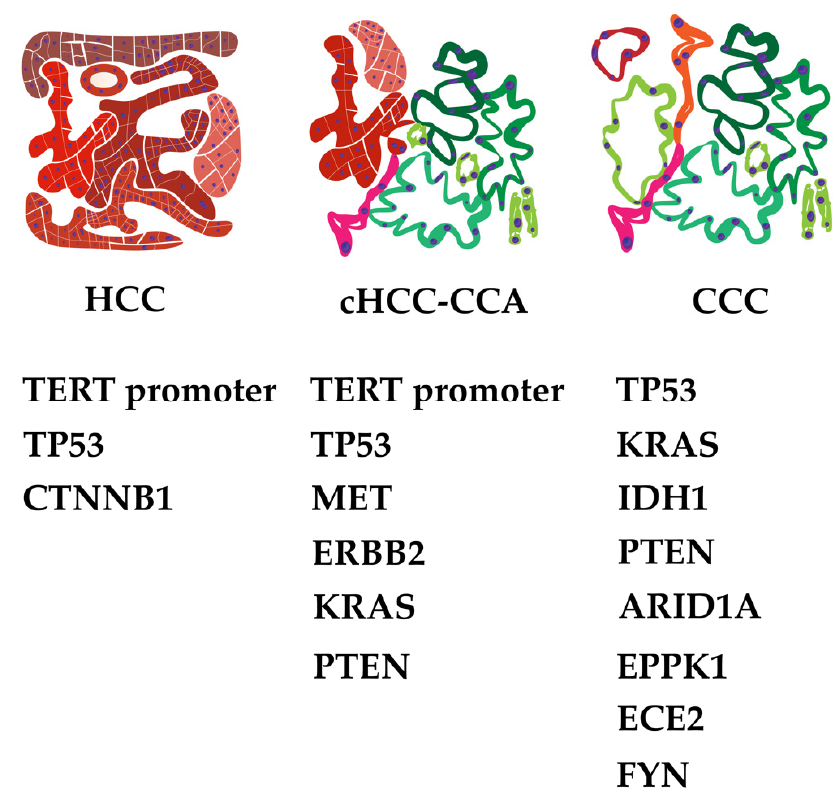
Figure 6. Most common mutational signatures in hepatocellular carcinoma (HCC), combined hepatocellular-cholangiocarcinoma (cHCC-CCA) and cholangiocarcinoma (CCC).